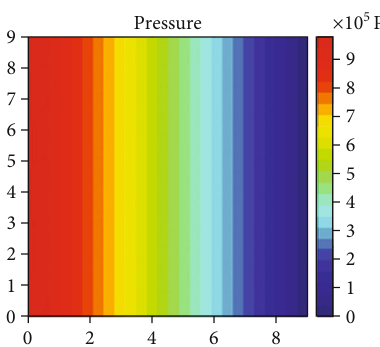
Figure 1: Pressure contour (Pa) for a reservoir with far- fi eld fl ow with a net e ff ective velocity of 35m/year from left to right. Initial reservoir pressure is zero. Scale of pressure change is relative to the right-end boundary of frame